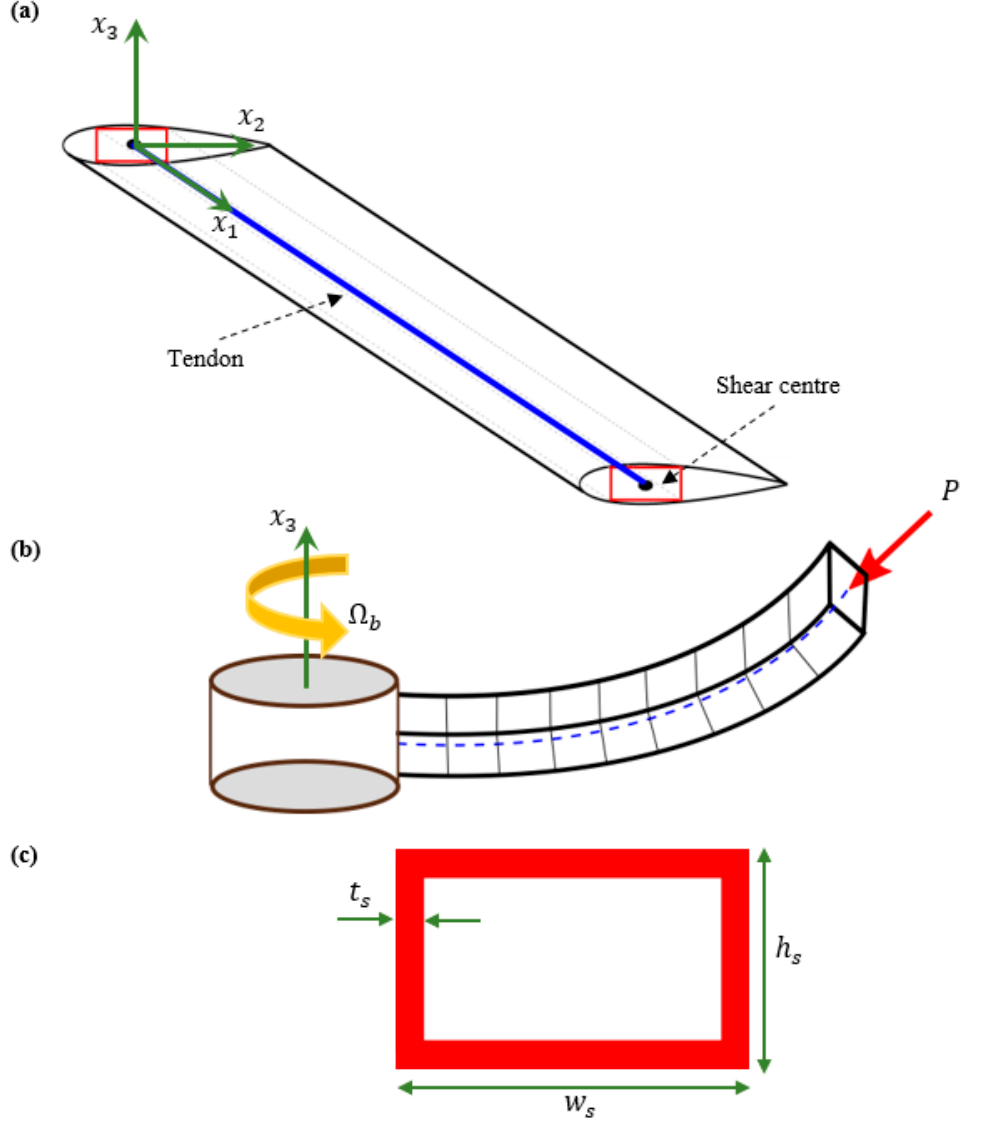
Figure 1. Schematic of the rotating composite blade subjected to the tendon induced axial force: ( a ) undeformed state, ( b ) tendon induced compressive force, ( c ) composite spar-box section.